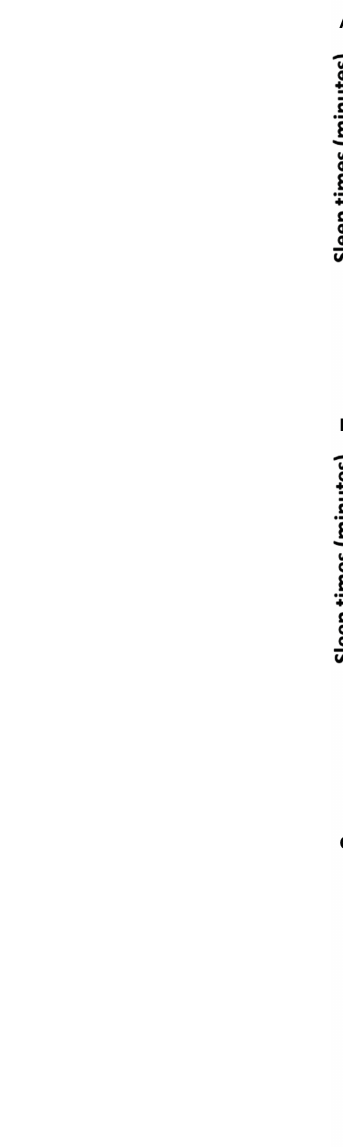
FIGURE 2 Actigraphy registered sleep variables ( A , total sleep time over 24h, B , total sleep time at night, C , total sleep time daytime) at baseline and following 4 months intervention for the overweight women with PCOS. Data given as mean with its 95% Con fi dence Interval calculated using a mixed model on an ITT basis. *P-value corrected for the confounder TST day using analysis of covariance. TST, total sleep